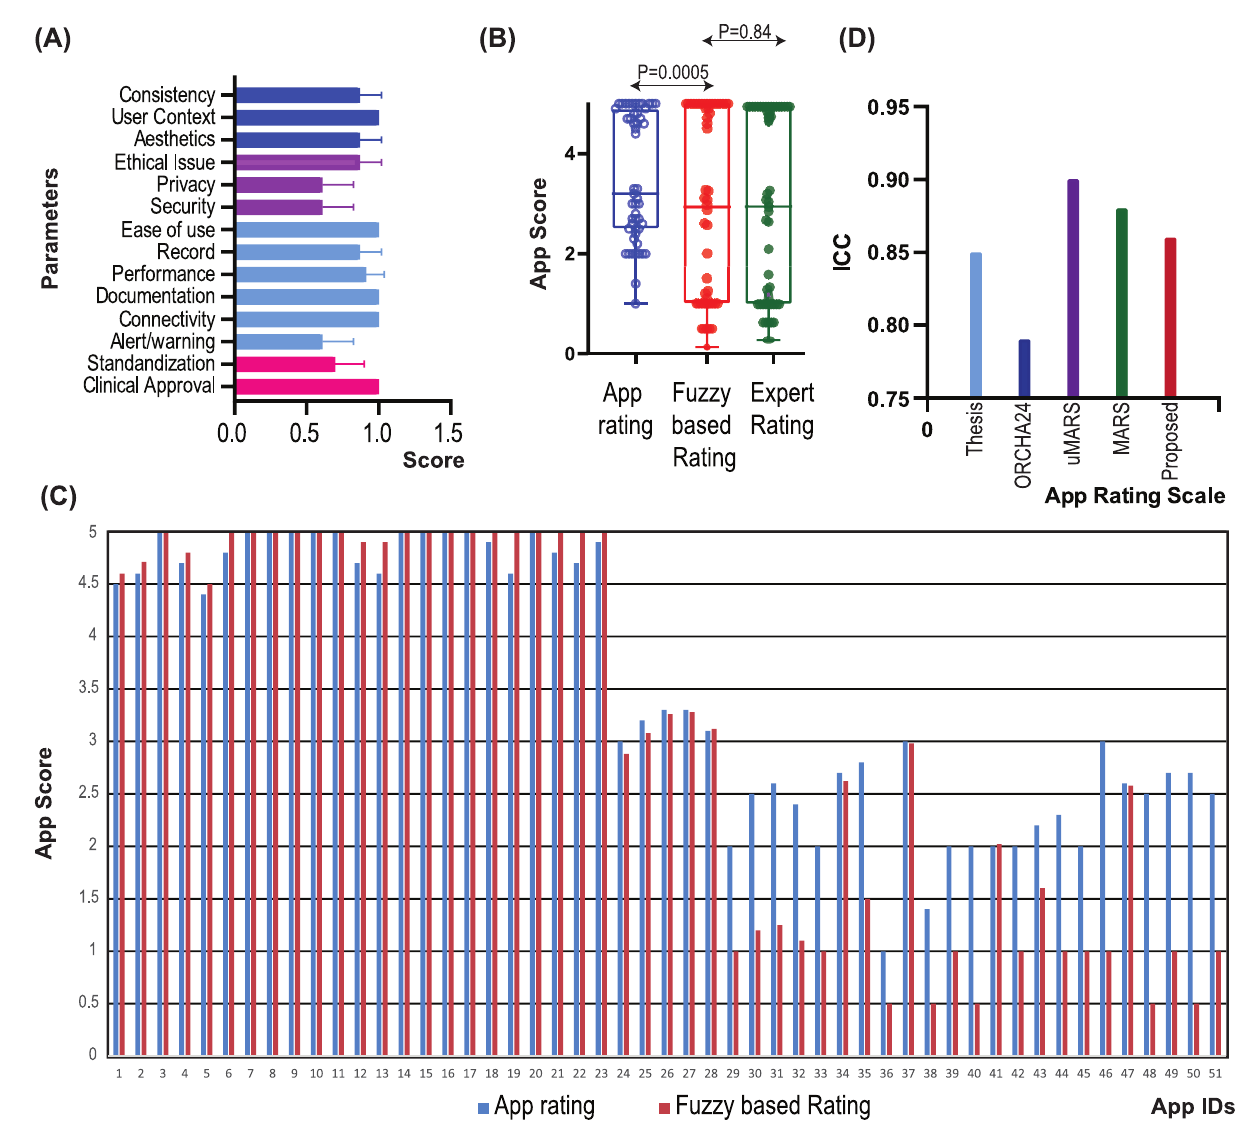
Fig 11. Comparison of traditional mobile app ratings and fuzzy based app ratings. (A) Average scores with respect to each parameter for all the selected 43 apps, (B) Box plot for the average rated value for traditional, fuzzy based ratings, as well as ratings based on expert opinion, (C) app scores for traditional and fuzzy based ratings for all the selected apps, and (D) Comparison of various app scales in terms of ICC.